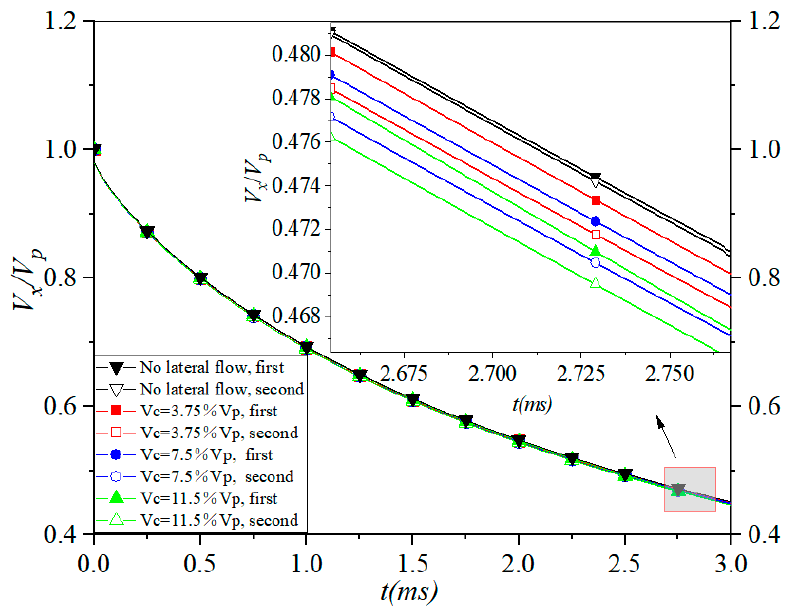
Figure 13. The change in the axial velocity of the parallel projectiles under different conditions.